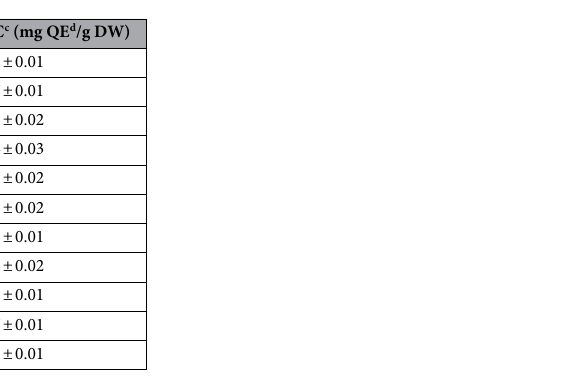
Table 2. Total phenolic and flavonoid content of studied Thymus species. Means with different letter are statistically significant at 5% level probability. a Total phenolic content. b Gallic acid equivalents. c Total flavonoid content. d Quercetin